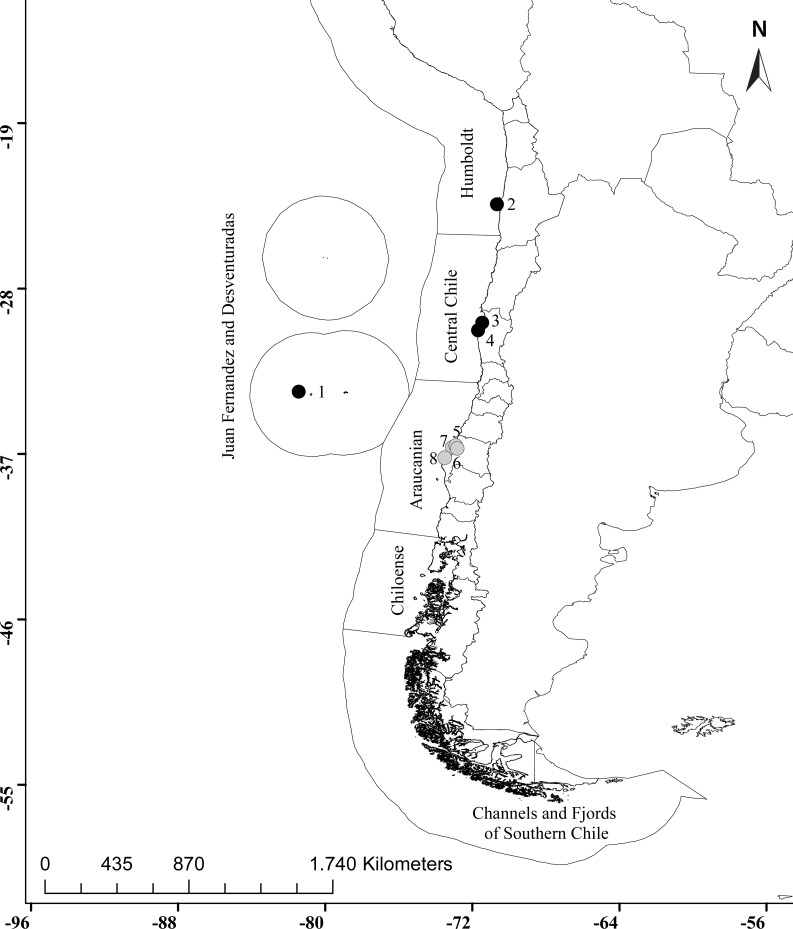
Distribution of Asterocarpa humilis along the Chilean coast.Black circles correspond to locations where A. humilis has been previously reported (1, Archipiélago Juan Fernández, Van Name, 1945; 2, Antofagasta, Clarke & Castilla, 2000; 3, Muelles UCN, Coquimbo; 4, Bahia Tongoy, Turon et al., 2016) and gray circles indicate the new four localities reported in this study (5, Coliumo; 6, Lirquén; 7, Talcahuano port; 8, Llico). Ecoregions are also shown (Spalding et al., 2007).